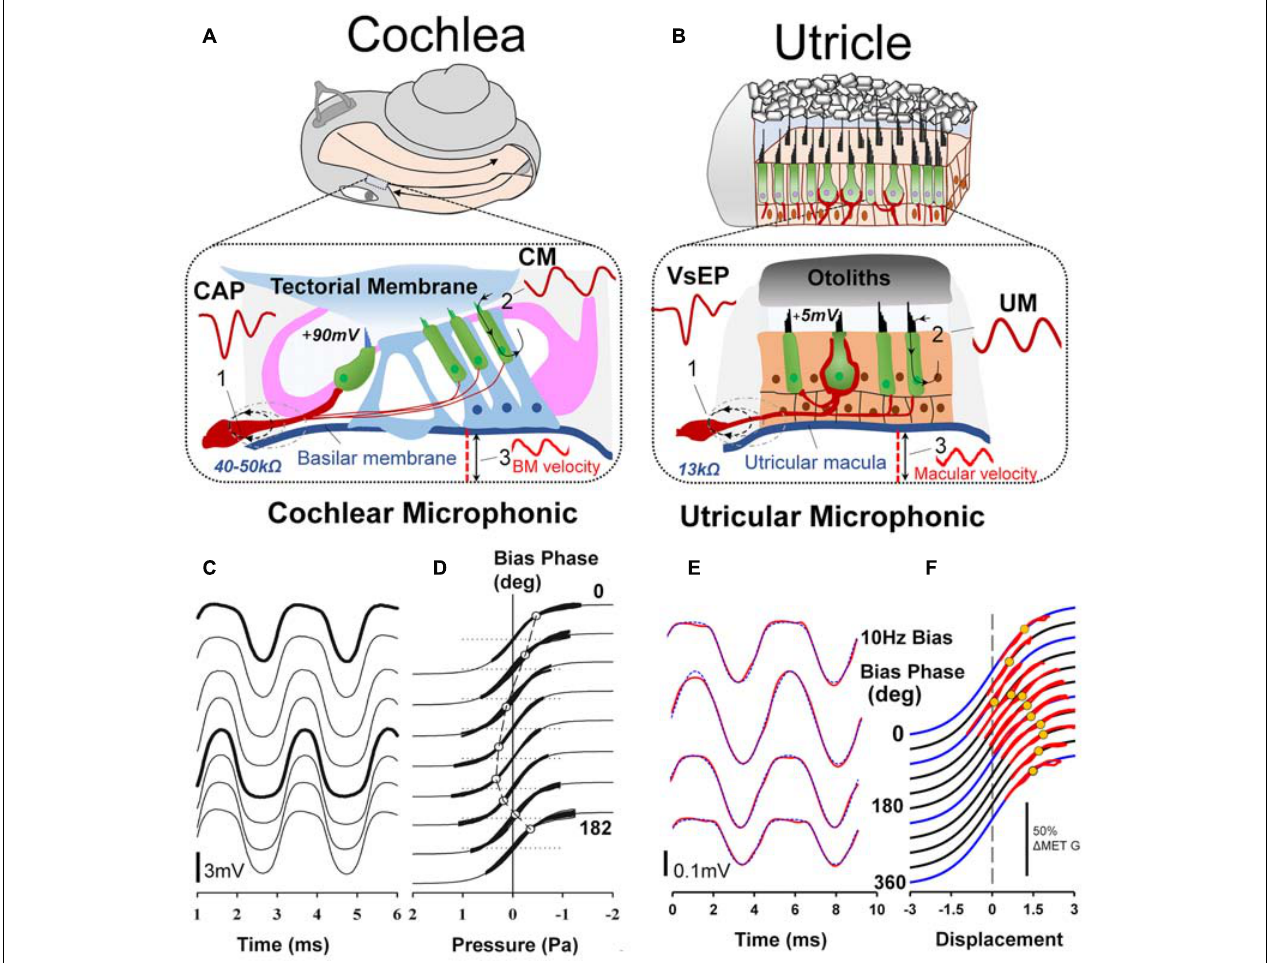
FIGURE 7 | (A) For decades auditory researchers have used objective measures of cochlear nerve, hair cell and mechanical function in the CAP, CM, and basilar membrane vibration to comprehensively investigate the cellular basis of hearing and associated disorders. (B) Analogous tools have recently been developed and characterized from the utricle, in the VsEP, UM and macular vibration to differentially assess peripheral vestibular function, in vivo . Reproduced (adapted) from Assessment of utricular nerve, hair cell and mechanical function, in vivo . Pg. 10. Doctoral Thesis. The University of Sydney. Christopher Pastras. 2018. With permission from Copyright owner Christopher Pastras. (C) Low-frequency (4.8 Hz) biased cochlear microphonic (CM) waveforms recorded from scala media of the basal turn in response to a 500 Hz, 90 dB SPL probe stimulus after injection of 0.5 µ L Healon gel, used to mimic endolymphatic hydrops in the cochlear apex. (D) Lissajous figures show the same CM waveforms (heavy lines) plotted against a sinusoidal input, displaced to best fit the transducer curve (thinner line). The open circle indicates the displacement, which corresponds to the operating point at that point on the bias cycle. Reproduced from Salt et al. (2009) Copyright Elsevier (Hearing Research). (E) 220Hz Utricular microphonic (UM) waveforms during a 10 Hz hydrodynamic bias of the utricular macula. (F) UMs plotted on a Boltzmann Lissajous curve representing MET channel gating, using the approximated macular displacement, which includes an estimate of the operating point with displacement (gray circles).Reproduced from Pastras et al. (2020) Copyright Springer (Journal of the Association for Research in